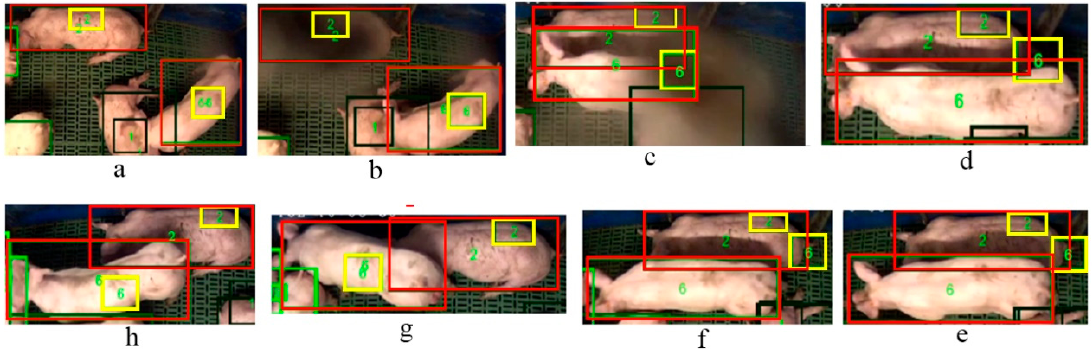
Figure 7. The example results of our method to tackle the occlusion of insect. The final detected and tracked bounding boxes are shown in red colour, the tag ‐ boxes are shown in yellow, and the unique ID numbers are shown in green. The sequence order is from frame ( a ) to ( h ).